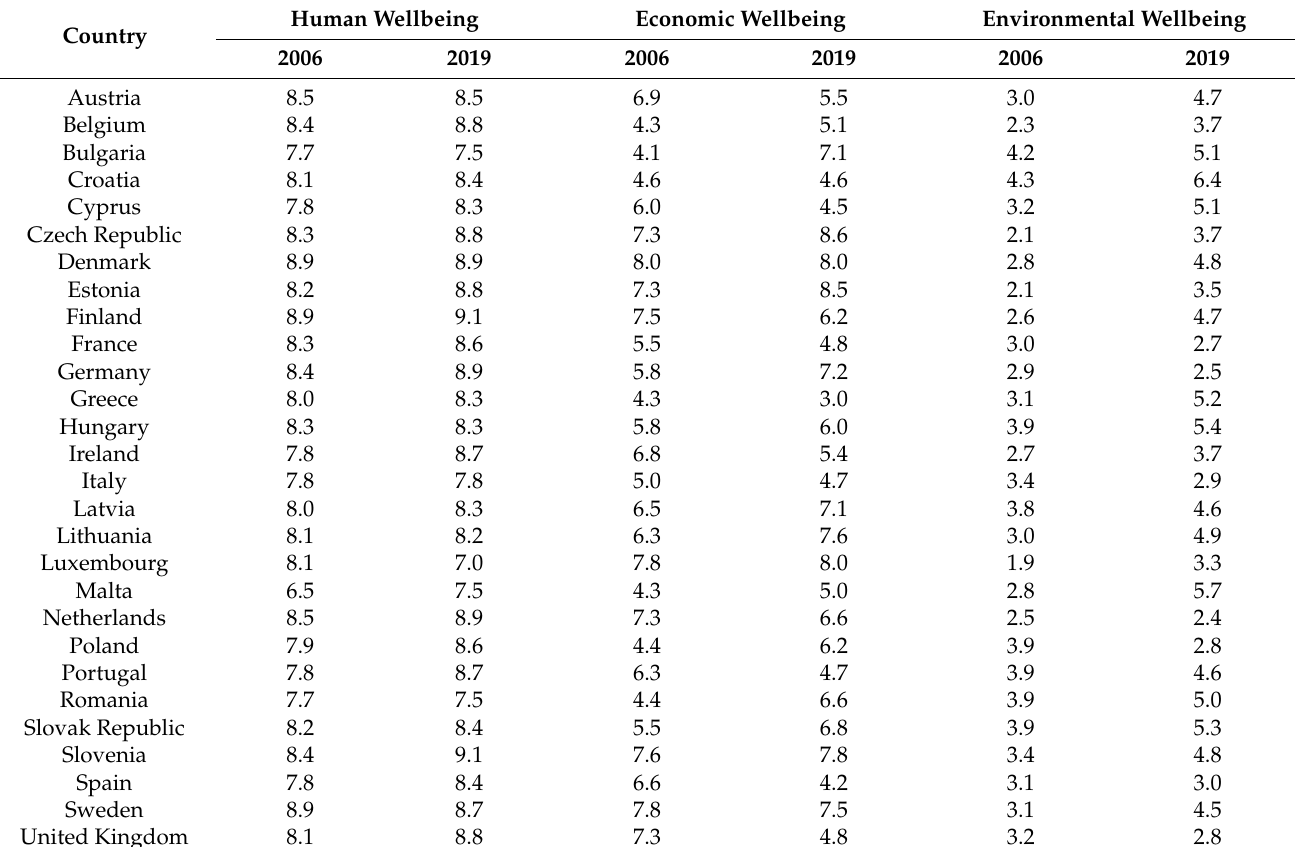
Table A1. Levels of human, economic, and environmental wellbeing in the European Union countries in 2006 and 2019. Country